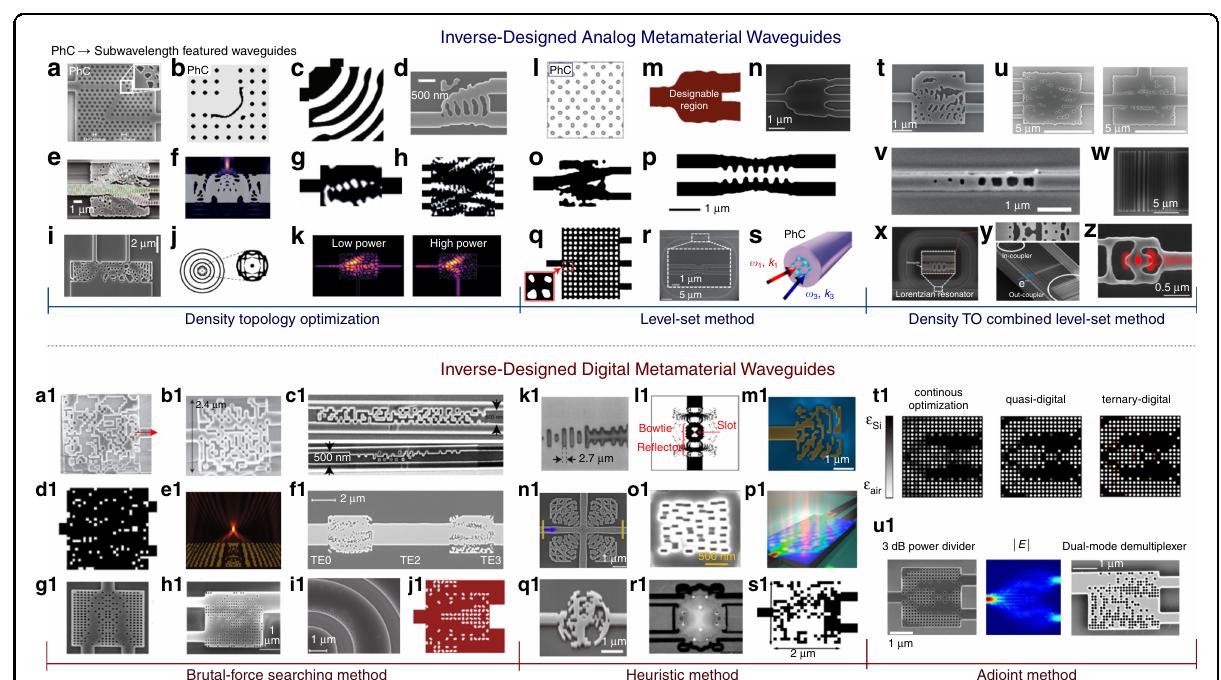
Fig. 11 Inverse-designed analog (a – z) and digital (a1 – u1) metamaterial waveguides. a – k Analog meta-waveguides inversely designed by density topology (TO) optimization. Note: non-subwavelength structures, like photonic crystals (PhC), are marked out. a A PhC waveguide Z-bend 373 and b 90° bend 374 . c Metamaterial waveguide 90° bend 375 . d Polarization beam-splitter (PBS) 376 . e 3-channel mode multiplexer (MUX) 377 . f Planar nanolens 378 . g TE 0 -TE 1 mode converter. h 3 × 3 hub 58 . i 2-channel wavelength de-MUX 387 . j Nonlinear microcavity 388 , k Optical Kerr switch 366 . l – s Level-set method. l A PhC with maximizing band gaps 390 . m 3 dB 367 and n 1 × 3 power splitter. o Dual-channel mode MUX. p 2 × 2 power splitter.